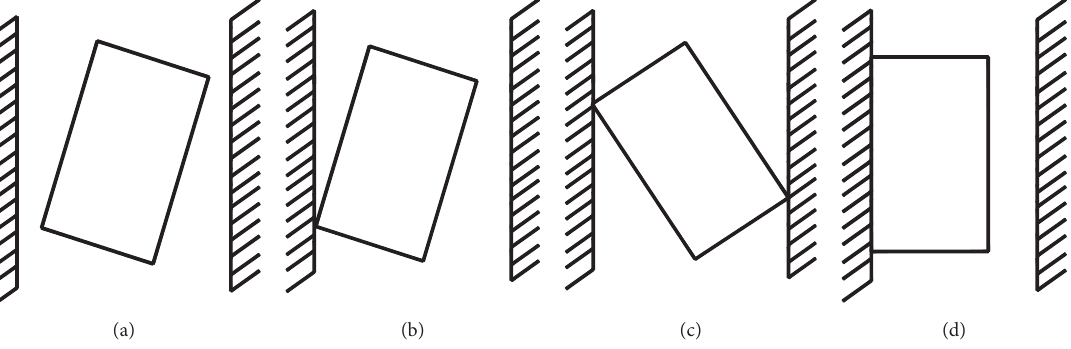
Figure 2: Relative position cases between slider and guide.